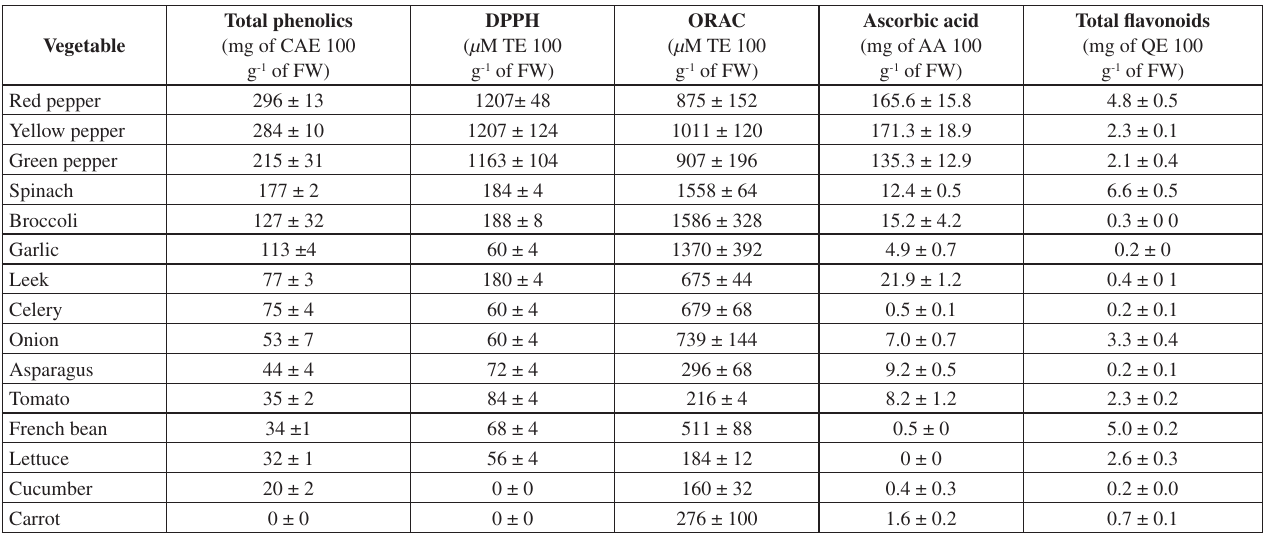
Table 5: Antioxidant Capacity (DPPH and ORAC) and vegetable content in total phenolics, ascorbic acid, and total flavonoids*